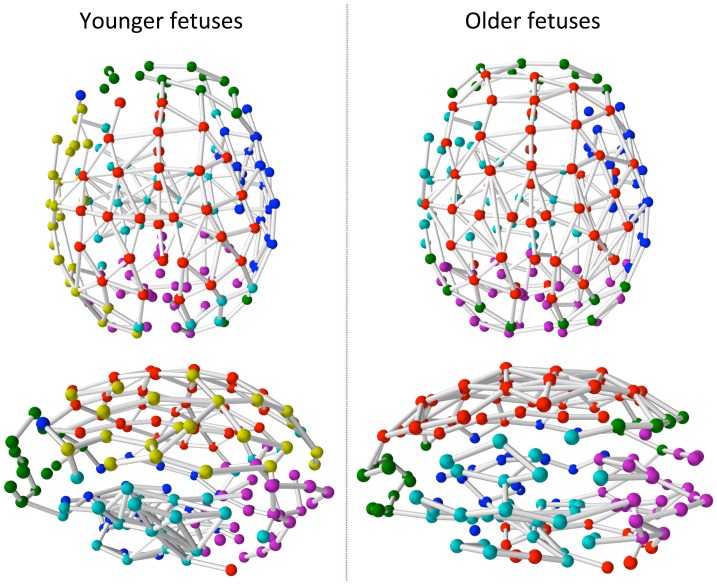
Macro-scale functional brain network modules for younger ( = 27.6 weeks; n = 17) and older ( = 34.4 weeks; n = 16) fetuses.Nodes are represented as colored spheres and edges are represented as the connections between nodes. Common colors are assigned to maximally similar modules in the two groups, but color assignments are arbitrary.